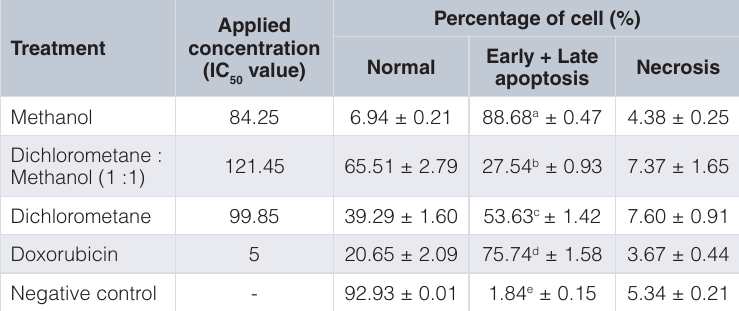
Table 2. Percentage of T47D cell population after treatment of crude extracts of Ancorina sp.